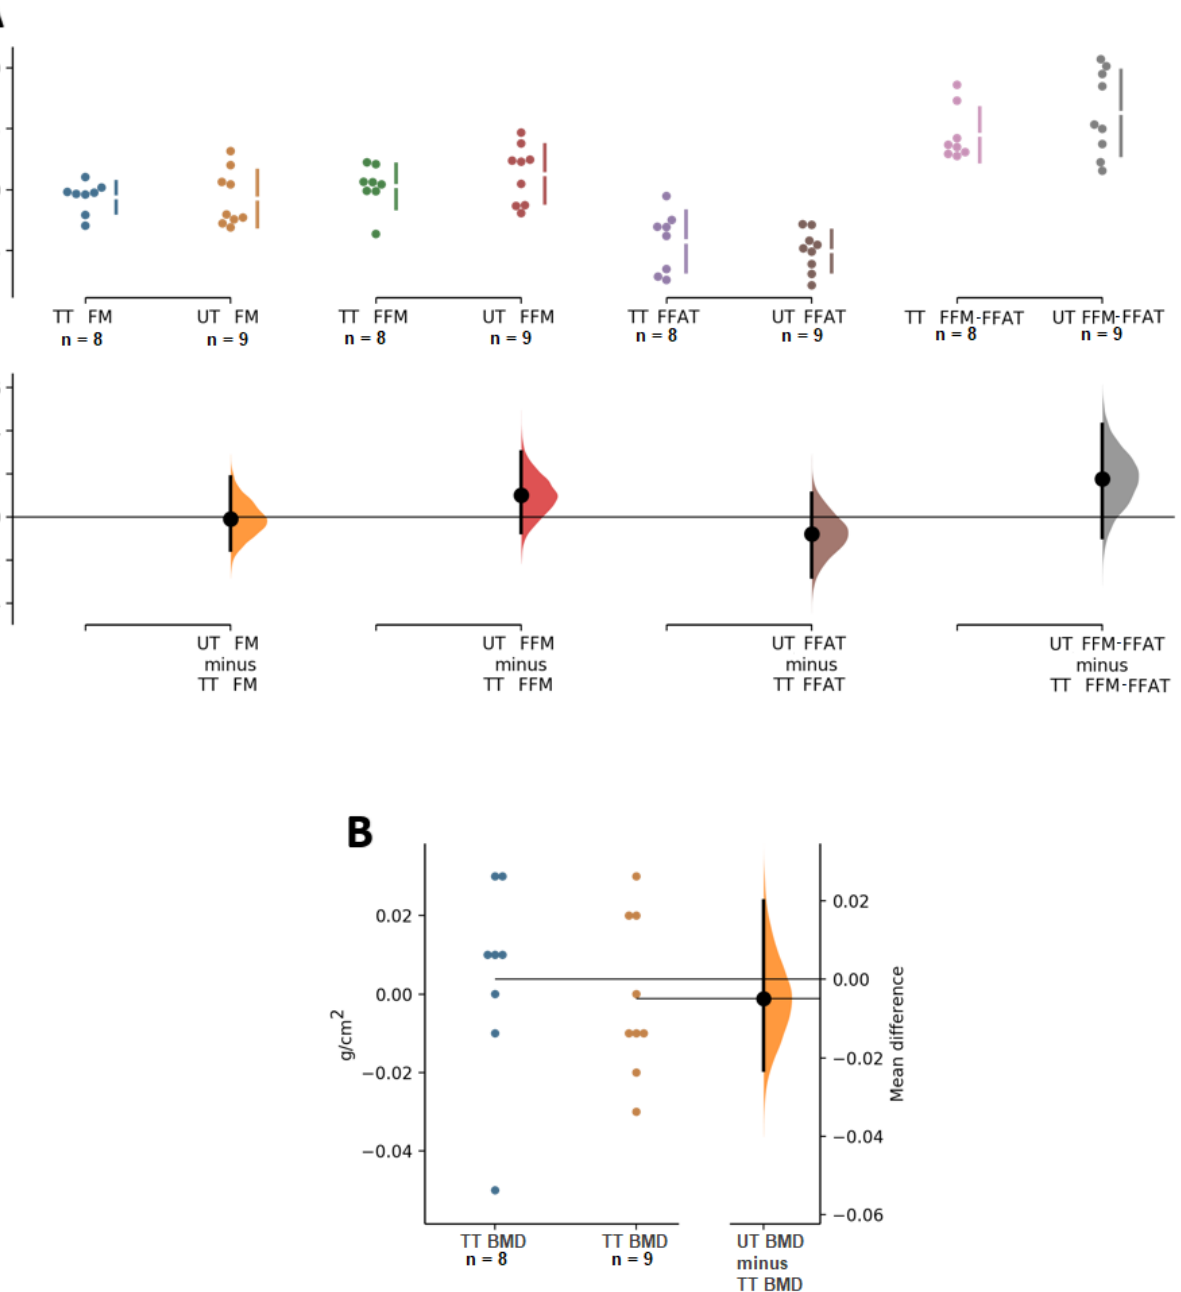
Figure 3. Paired Cumming estimation plots of body composition variables. ( A ) FM, fat mass; FFM, fat free mass; FFAT, Fat-free adipose tissue, and FFM-FFAT, fat free mass corrected for fat-free adipose tissue. ( B ) BMD, bone mineral density. TT, traditional training; UT, undulating training. Both groups are plotted on the left axes; the mean difference is plotted on a floating axis on the right as a bootstrap sampling distribution. The mean difference is depicted as a dot; the 95% confidence interval is indicated by the ends of the vertical error bar [28] .